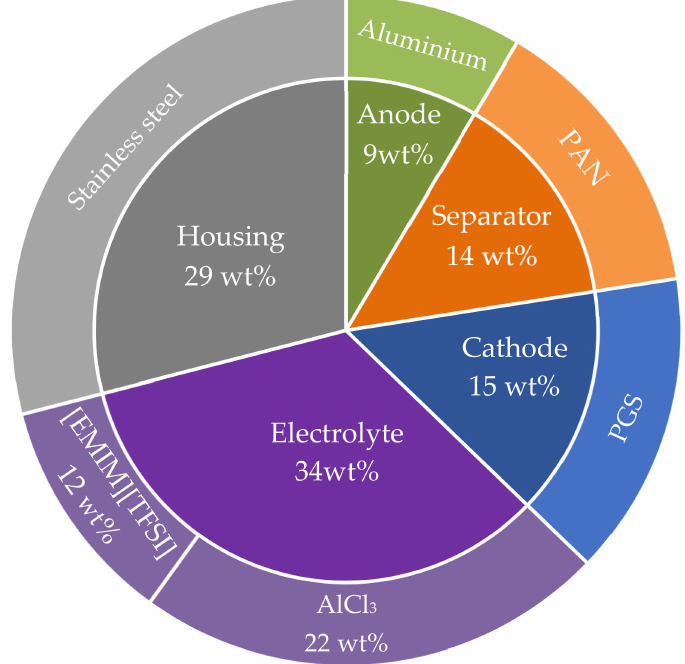
Figure 2. Material composition of the Al-ion 18650 battery. Weight-wise, the electrolyte is the main component accounting for the 34 wt % of the cell’s weigh. The housing shares 29 wt %, the cathode 15 wt %, the separator 14 wt % and the anode 9 wt %.3.2.2. Use